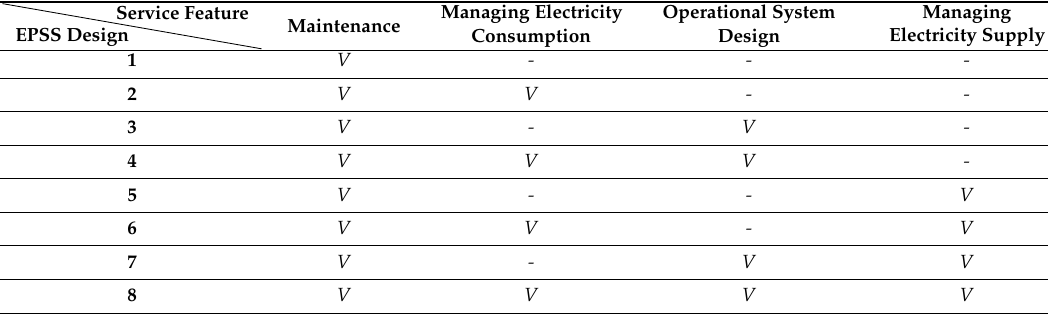
Table 4. Simulated EPSS Service